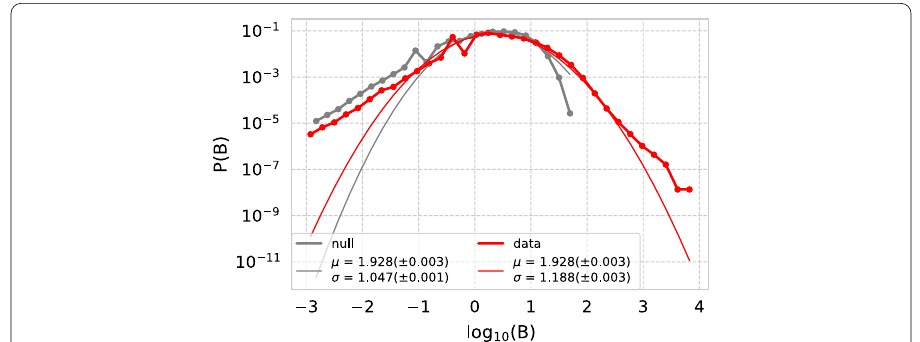
Fig. 12 Distribution of B in the dataset and null model. The thin line is the result of log-normal fitting using the maximum likelihood method on each data